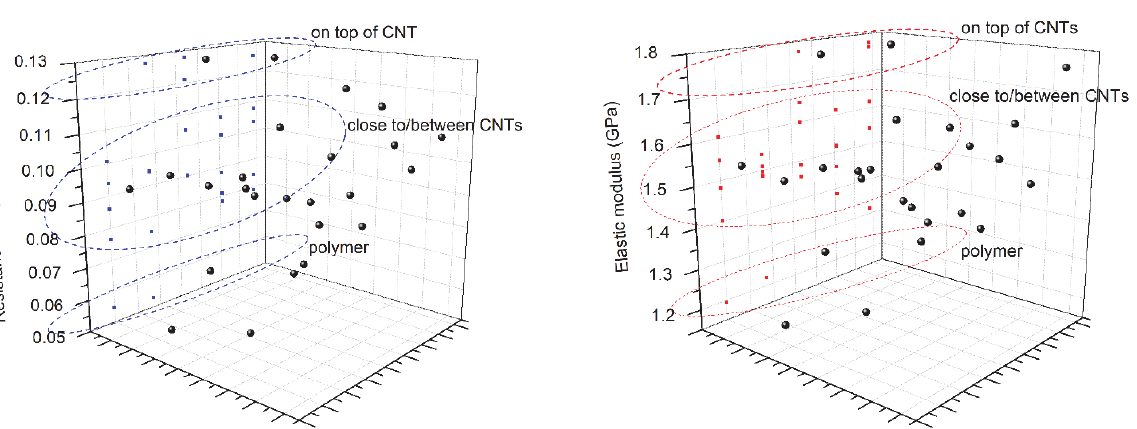
Figure 11: Elastic modulus mapping, at 300 nm of displacement